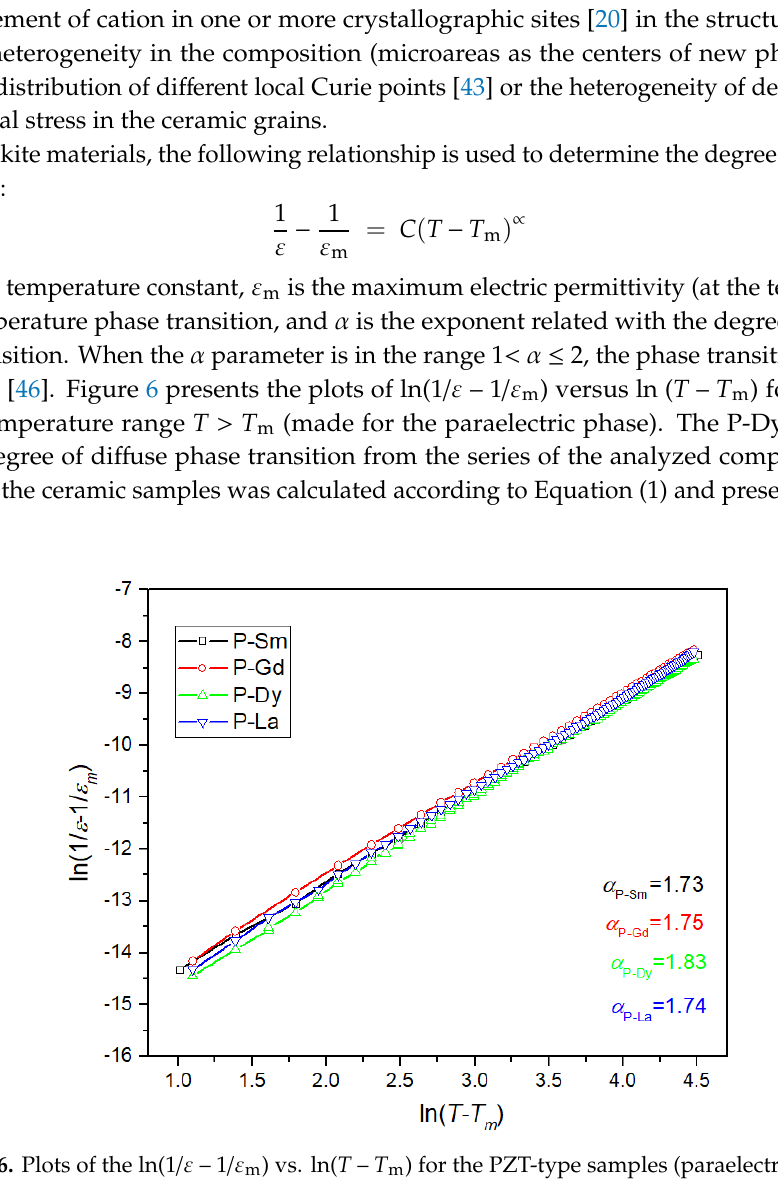
Figure 6. Plots of the ln(1/ ε – 1/ ε m ) vs. ln( T – T m ) for the PZT-type samples (paraelectric phase)